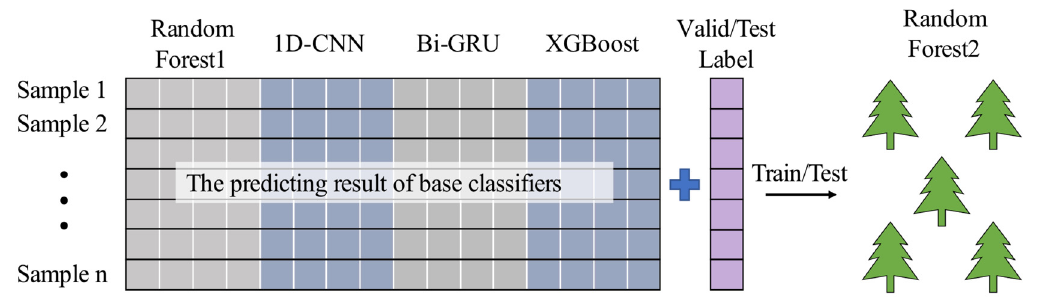
Figure 14. The integration process of base classifiers.